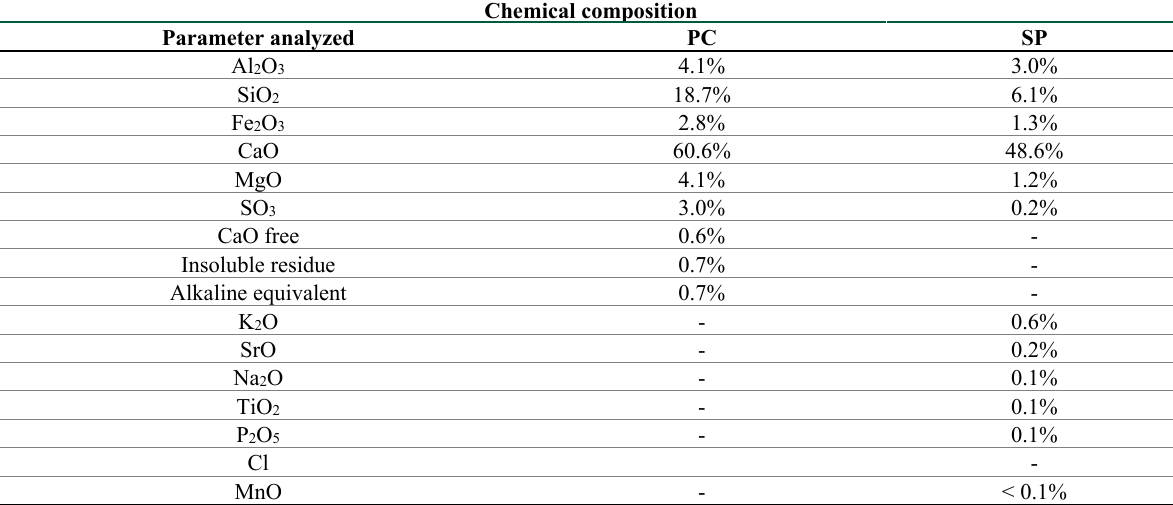
Table 1. X-ray fluorescence of the fine